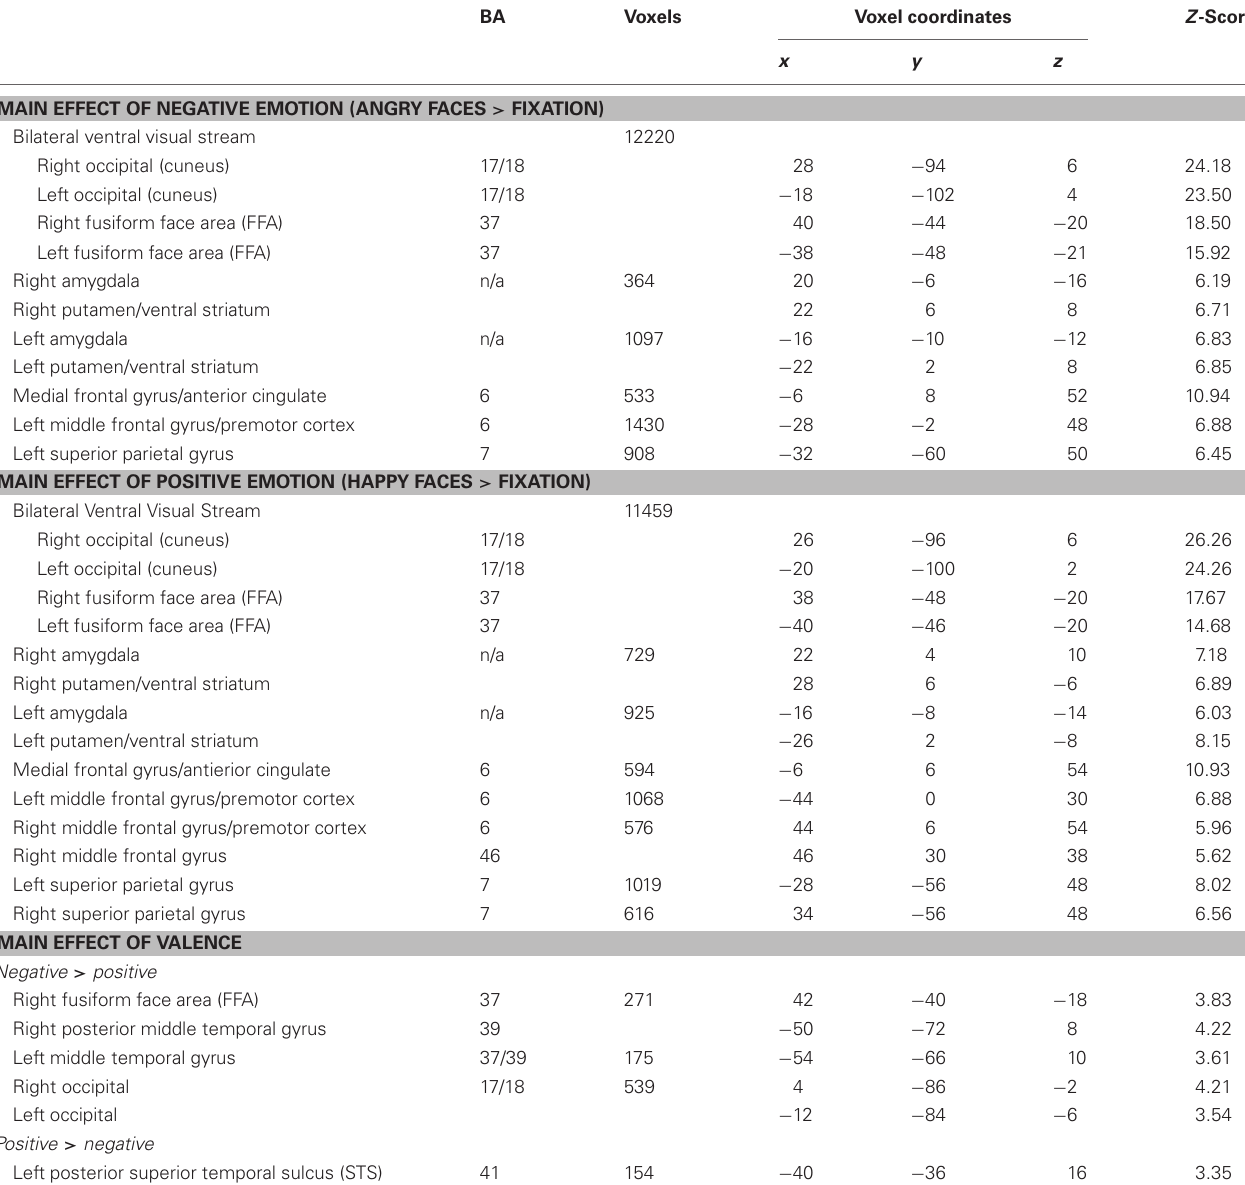
Table 3 | Regions involved in negatively and positively valenced face processing (task minus fixation baseline contrast, p = 0 . 05 corrected). BA Voxels Voxel coordinates Z -Score x y